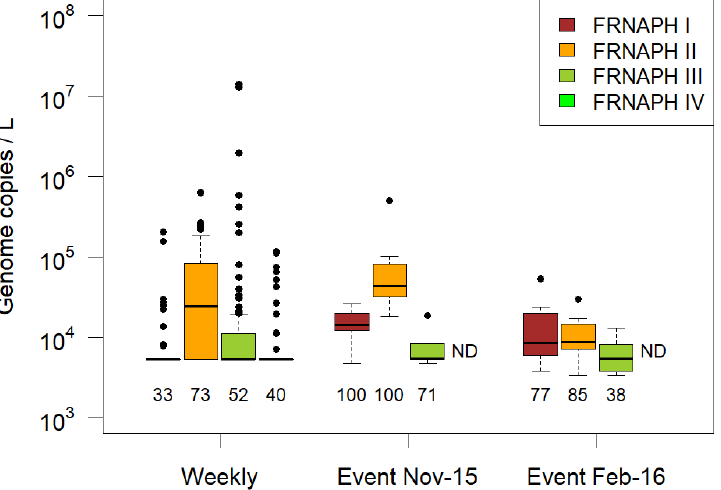
Figure 5. Concentration of genome copies of F-specific RNA bacteriophage (FRNAPH) I, II, III and IV measured in the weekly samples and during the storm runoff events occurring in November 2015 and February 2016. The genogroup FRNAPH IV was not measured in the samples collected during the runoff events. Numbers below the boxes indicate % of samples from which genome copies were detected.